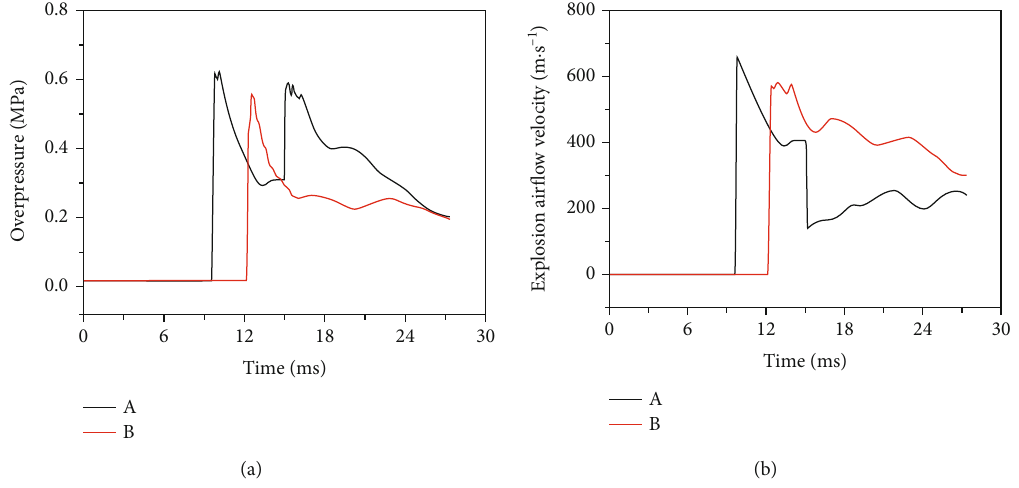
Figure 9: Relationships between the overpressure and air fl ow velocity at di ff erent moments before and after the bend ( V = 0 : 23m 3 , α = 90 ° ).